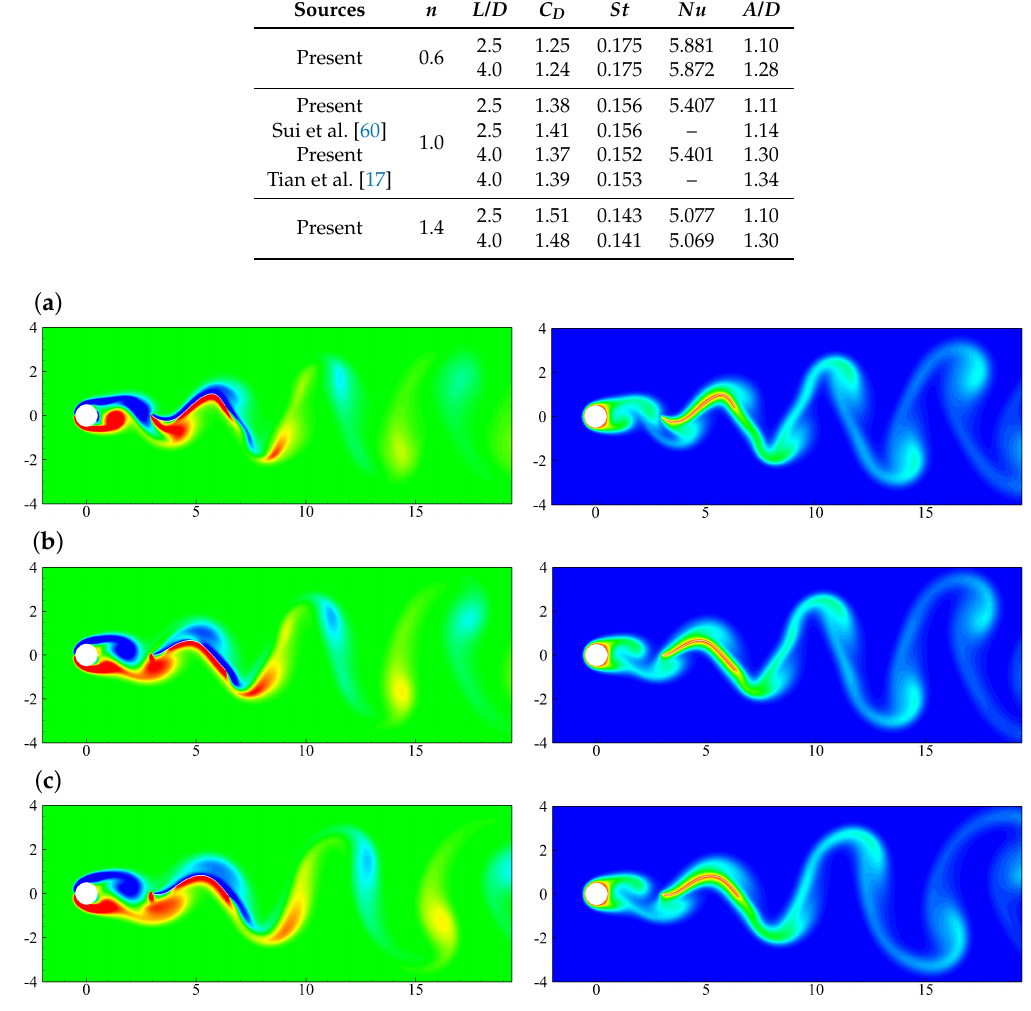
Figure 8. Instantaneous vorticity (left column, ranging from − 2 U 0 / D to 2 U 0 / D ) and temperature (right column, ranging from 0 to 1.0) contours at Re = 100, Pr = 1.0: ( a ) n = 0.6; ( b ) n = 1.0; ( c ) n =